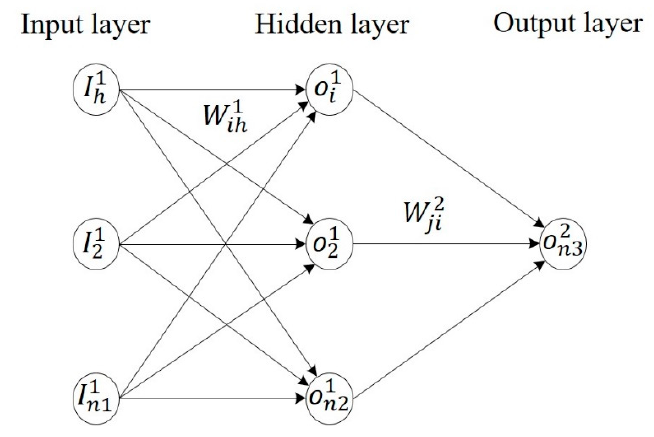
Figure 2. Structure of a multilayer perceptron (MLP) algorithm.